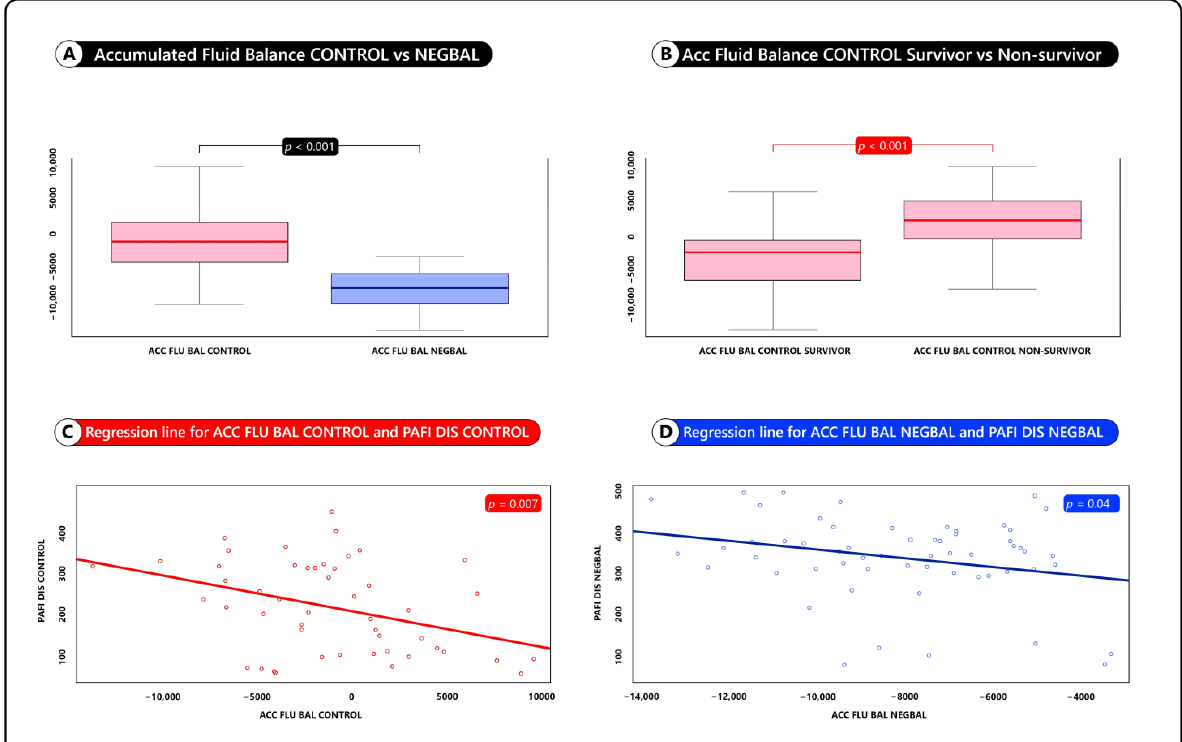
Figure 2. Accumulated fluid balance analysis. ( A ) Box plot of accumulated fluid balance CONTROL vs. NEGBAL. ( B ) Box plot of accumulated fluid balance CONTROL survivor vs. non-survivor. ( C ) Regression line for ACC FLU BAL CONTROL and PAFI DIS CONTROL. ( D ) Regression line for ACC FLU BAL NEGBAL and PAFI DIS NEGBAL.